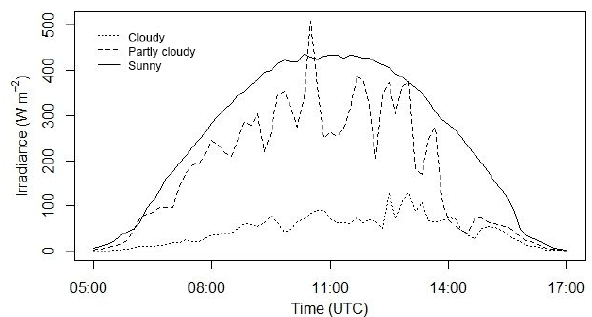
Figure 2. Example of daily profiles of the 10min broadband irra- diance for three different days in March 2015: cloudy day on 14th, partly cloudy day on 15th, and sunny day on